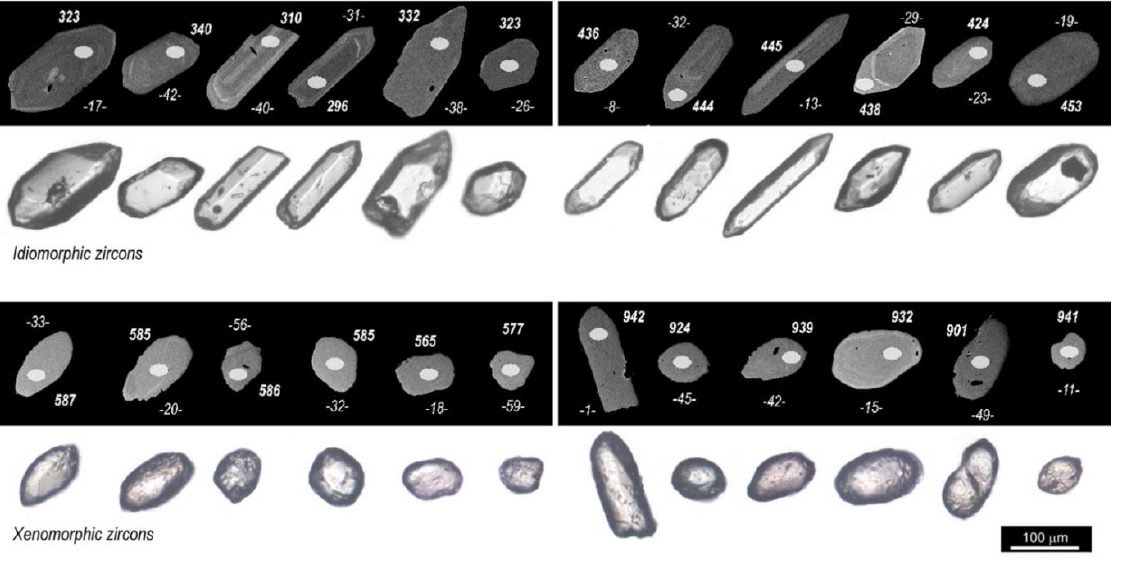
Figure 9. BSE images and optical photomicrographs of analysed zircons from Gu-35-2 sample (my- lonitic migmatite). Ellipses mark analytical spot locations and the text shows spot names (italics) and 208 Pb/ 236 U age in Ma (bold).